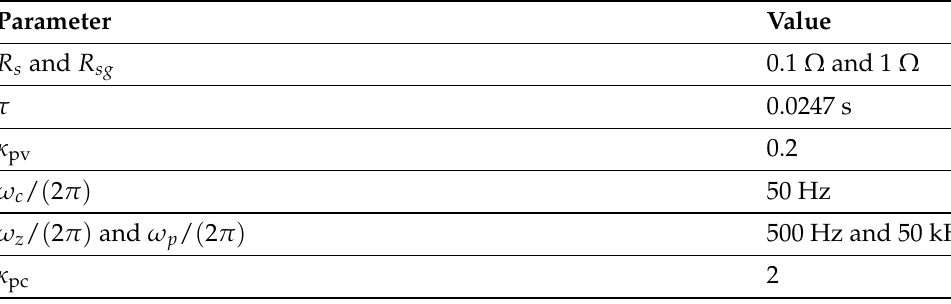
Table 2. Parameter values of the controllers.